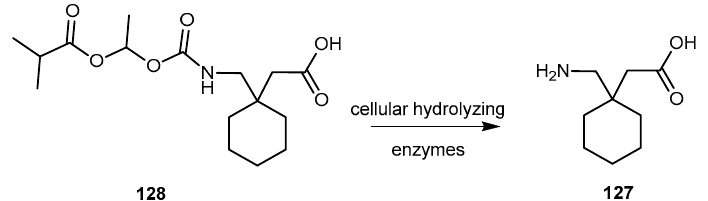
Figure 50. Bioconversion of XP13512 ( 128 ) to parent drug ( 127 ) by cellular hydrolyzing enzymes (Adapted from [4]).